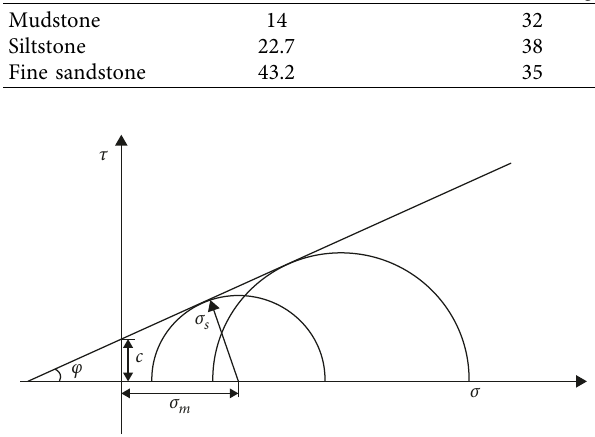
Figure 3: Illustration of Mohr–Coulomb yield criterion.